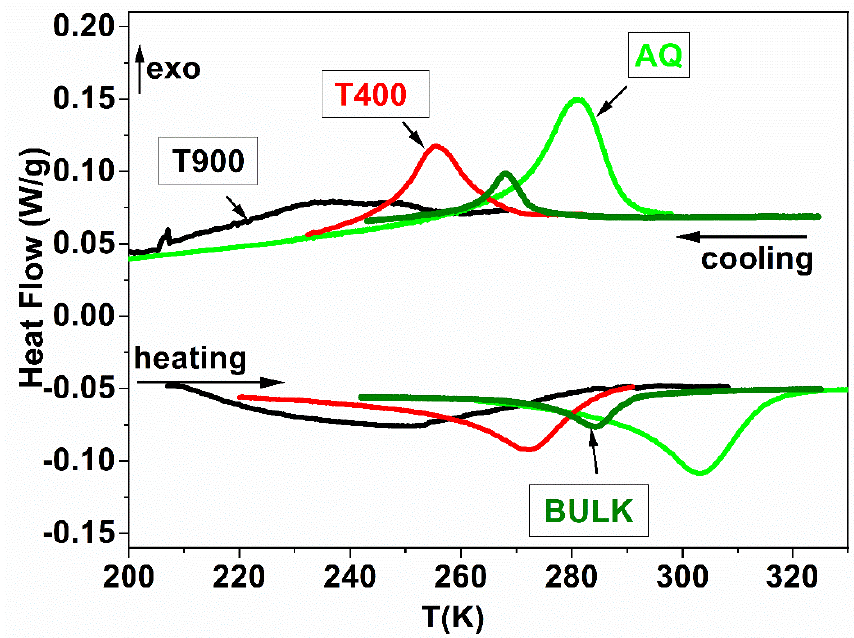
Figure 1. The DSC signals for Bulk and AQ, T400 and T900 ribbons. Table 1. DSC transformation temperatures (Ms, Mf, As, Af), thermodynamic equilibrium tempera- ture T 0 , the Curie temperatures (T CM , T CA ) and magnetic entropy change ΔS m (at 5 T) for studied samples. Tc A is determined on cooling and Tc M is determined on heating.